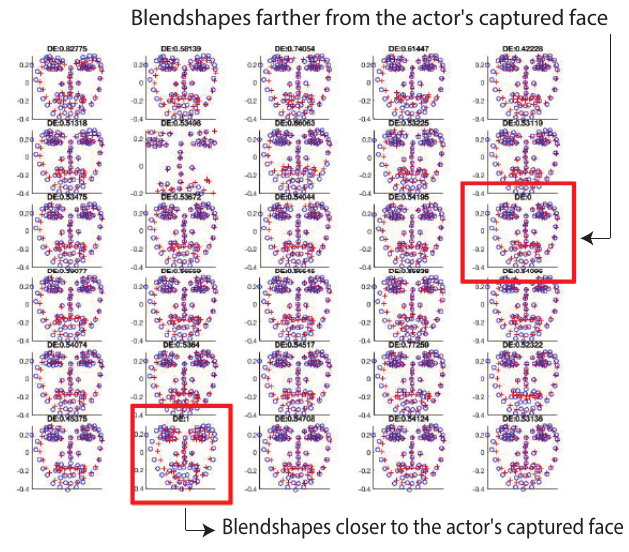
Fig. 6. Example of calculating the distances between the points of the captured face of the actor with the blendshapes